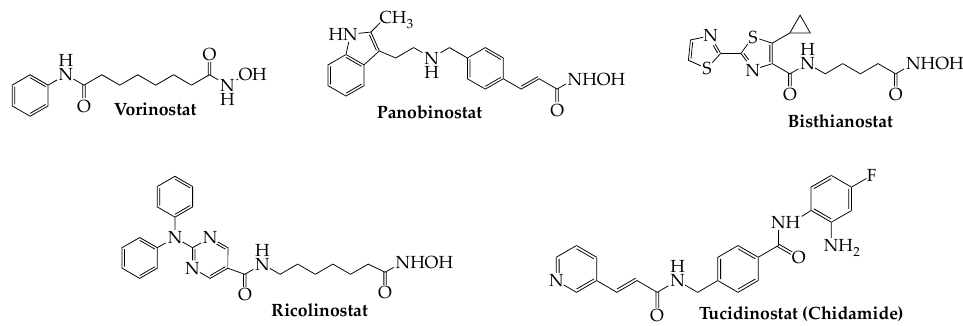
Figure 4. Structures of Histone Deacetylase Inhibitors Active Against MM. Table 2. Selected Myeloma-based Trials of Vorinostat.